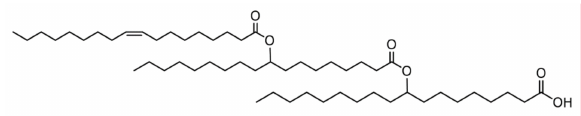
Figure 5. General structure of